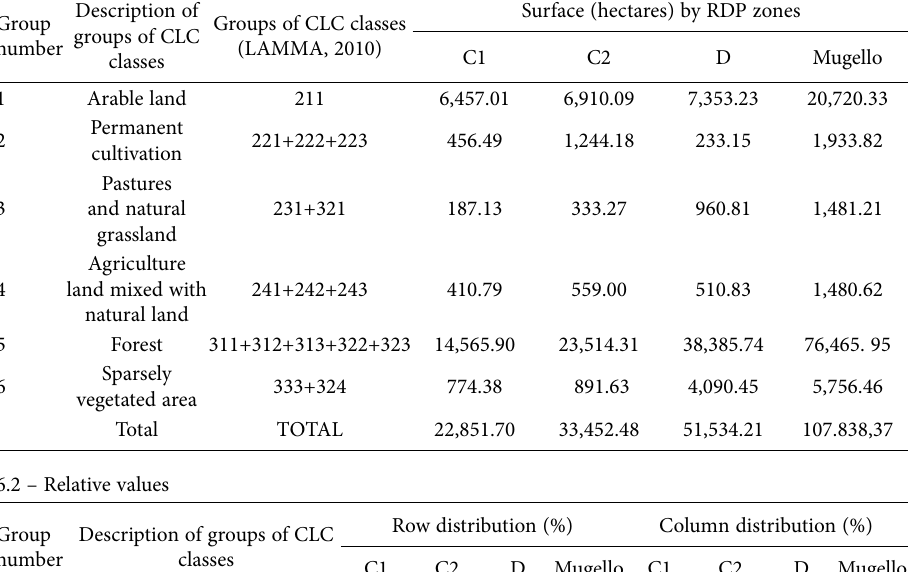
Table 6. Distribution of Corine land cover (CLC) classes in Mugello RDP zones. C1: Intermediate rural areas in transition; C2: Declining intermediate rural areas; D: Rural areas with development problems. 6.1 – Absolute values